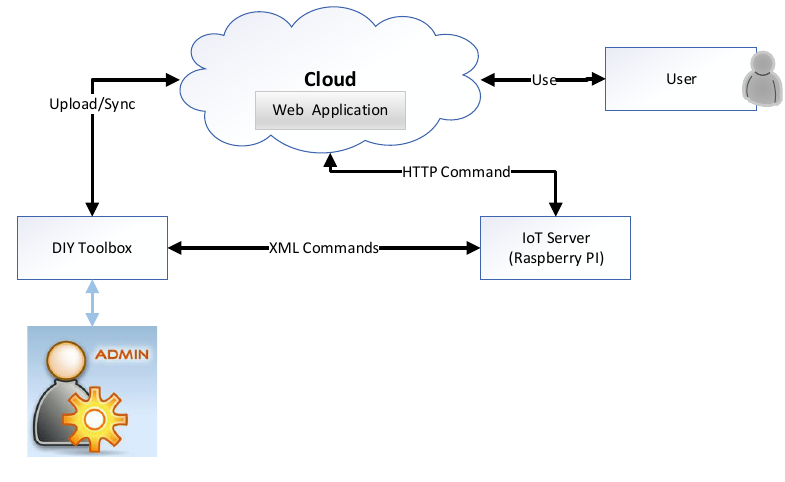
Figure 2. Conceptual